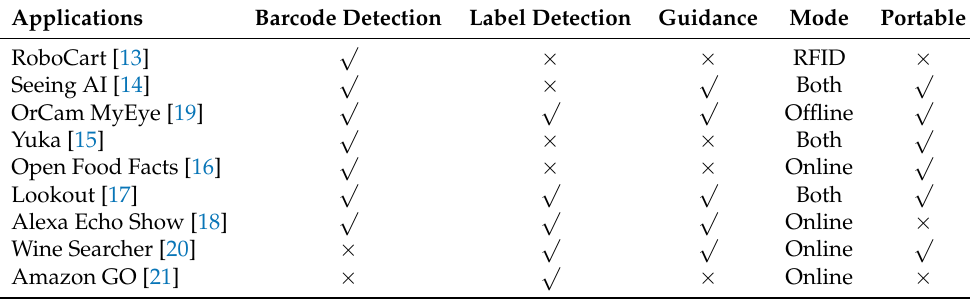
Table 1. Comparison between existing technological